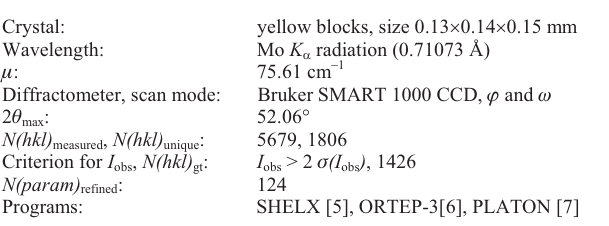
Table 1. Data collection and handling.